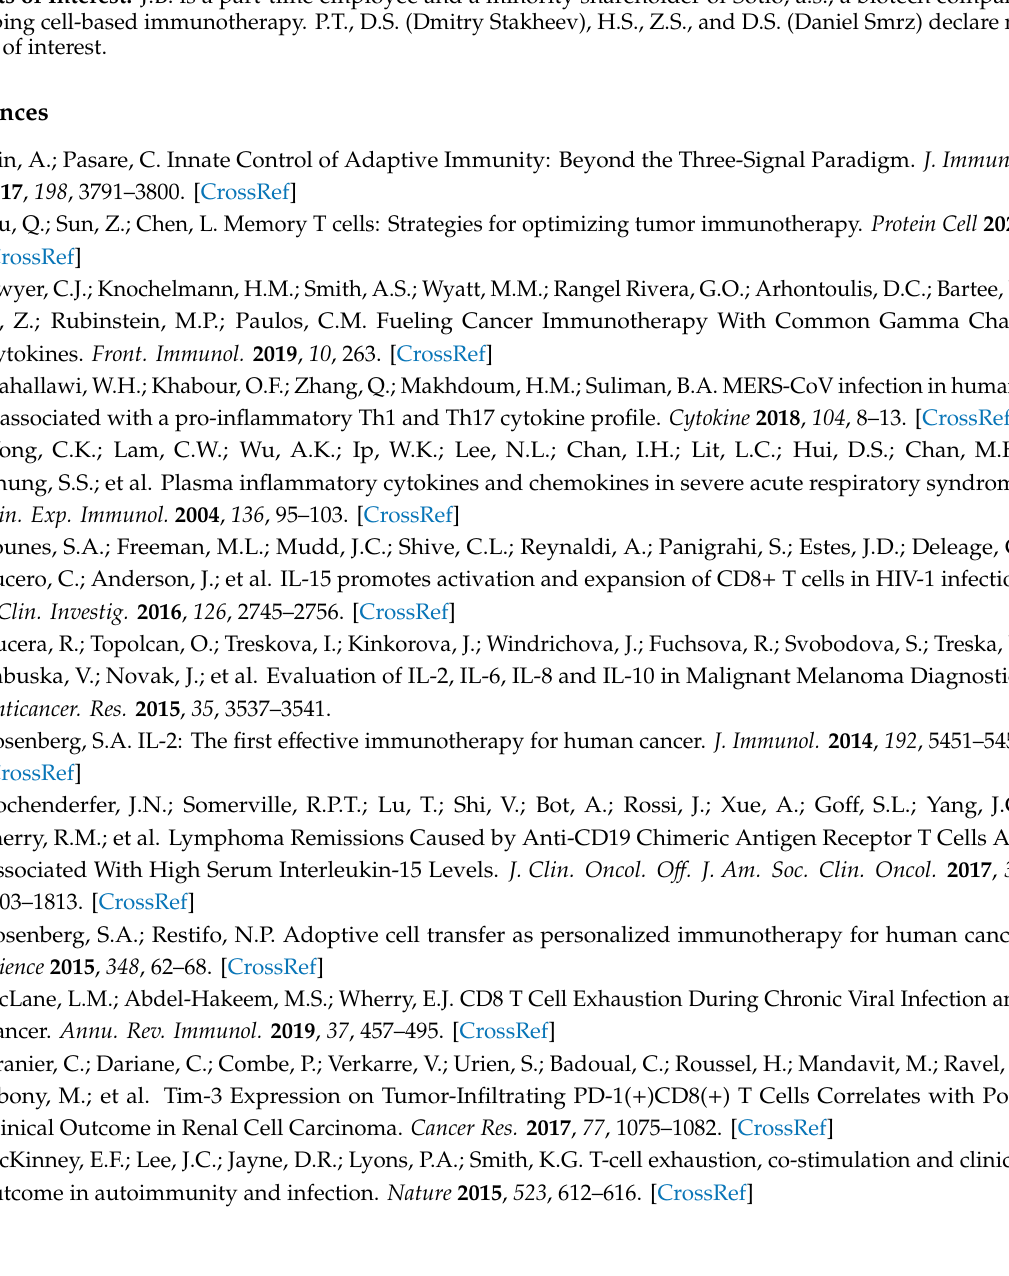
Figure S1: Preparation of mature monocyte-derived DCs, Figure S2: Enrichment and expansion of antigen-specific CD8 + T cells, annexin V staining, β -catenin translocation, and phospho